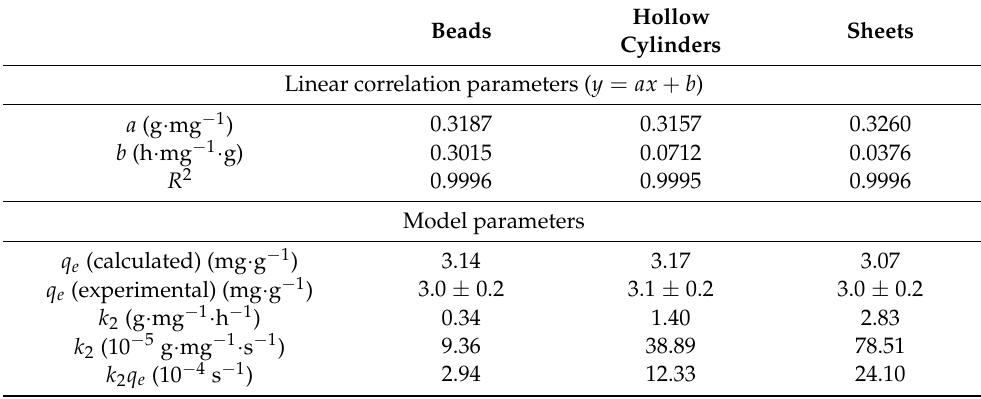
Figure 5. Concentration of the Rose Bengal lactone in the liquid phase, over time. Jar-test experiments. Table 4. Linear correlation and parameters of the pseudo-second-order kinetics model for the adsorption of Rose Bengal lactone into solid media. Jar-test experiments.